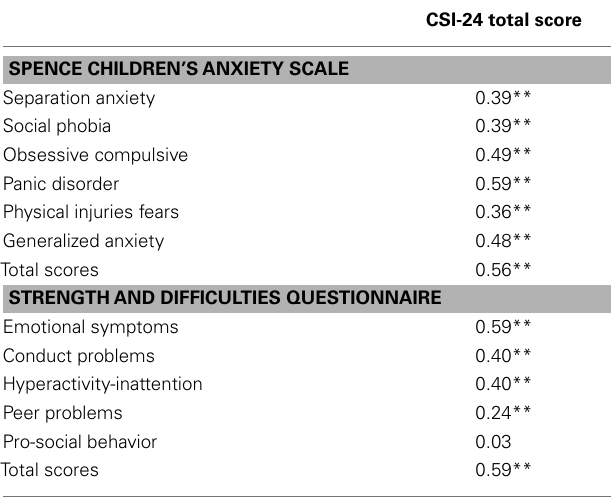
Table 4 | Correlations between CSI-24 and other psychopathological